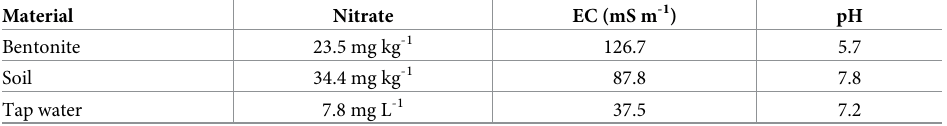
Table 1. Nitrate, electrical conductivity (EC) and pH of bentonite clay material, soil and tap